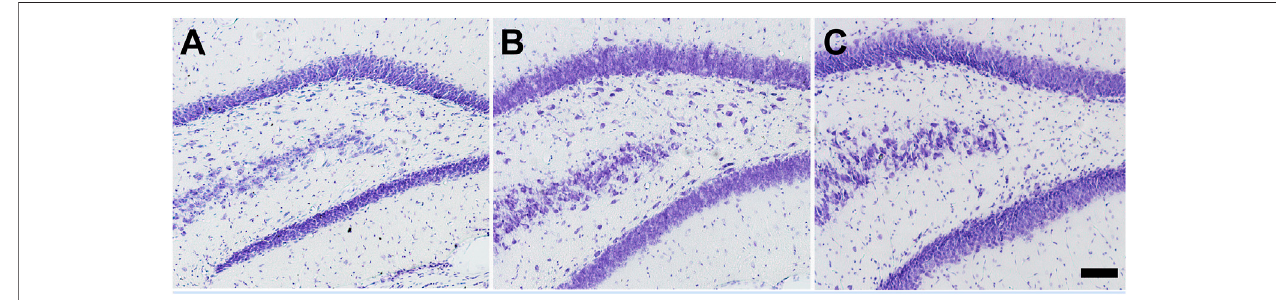
FIGURE 3 | Photomicrographs of Nissl staining in the hilus of the hippocampus 90 days after pilocarpine injection. (A) Control (B) NoSE (C) SE animal. Note intense neuronal loss in SE group as compared to controls and NoSE groups. Scale bar: 100 μ m.